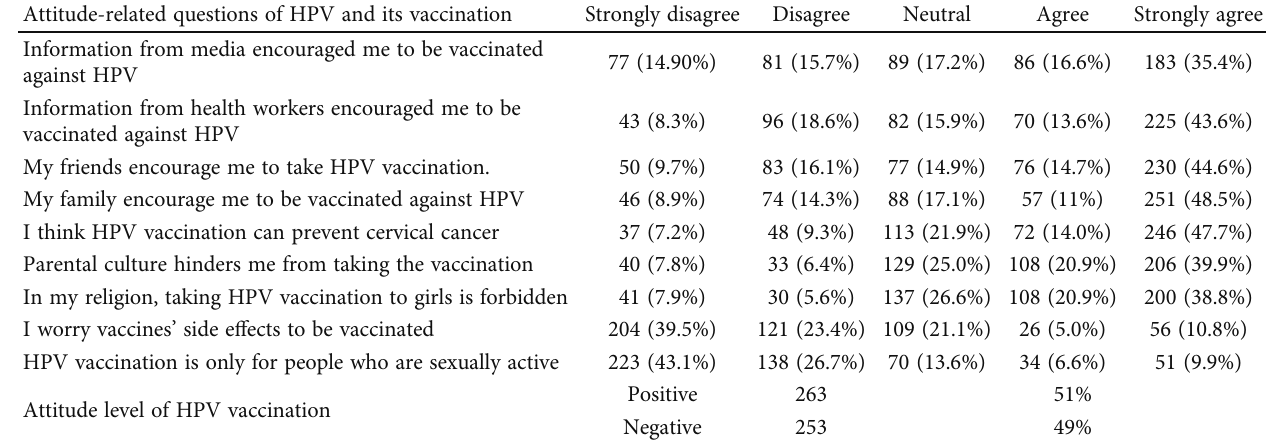
Table 3: Attitude of girl students towards HPV vaccination in Arba Minch town, Southern Ethiopia, 2020. Attitude-related questions of HPV and its vaccination